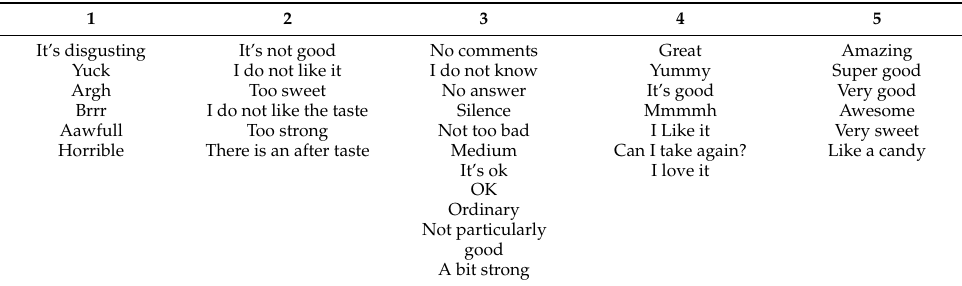
Figure A1. Hedonic Five Scake Facial Expression. Table A1. Spontaneous Verbal Response adapted from Sjovall et al.